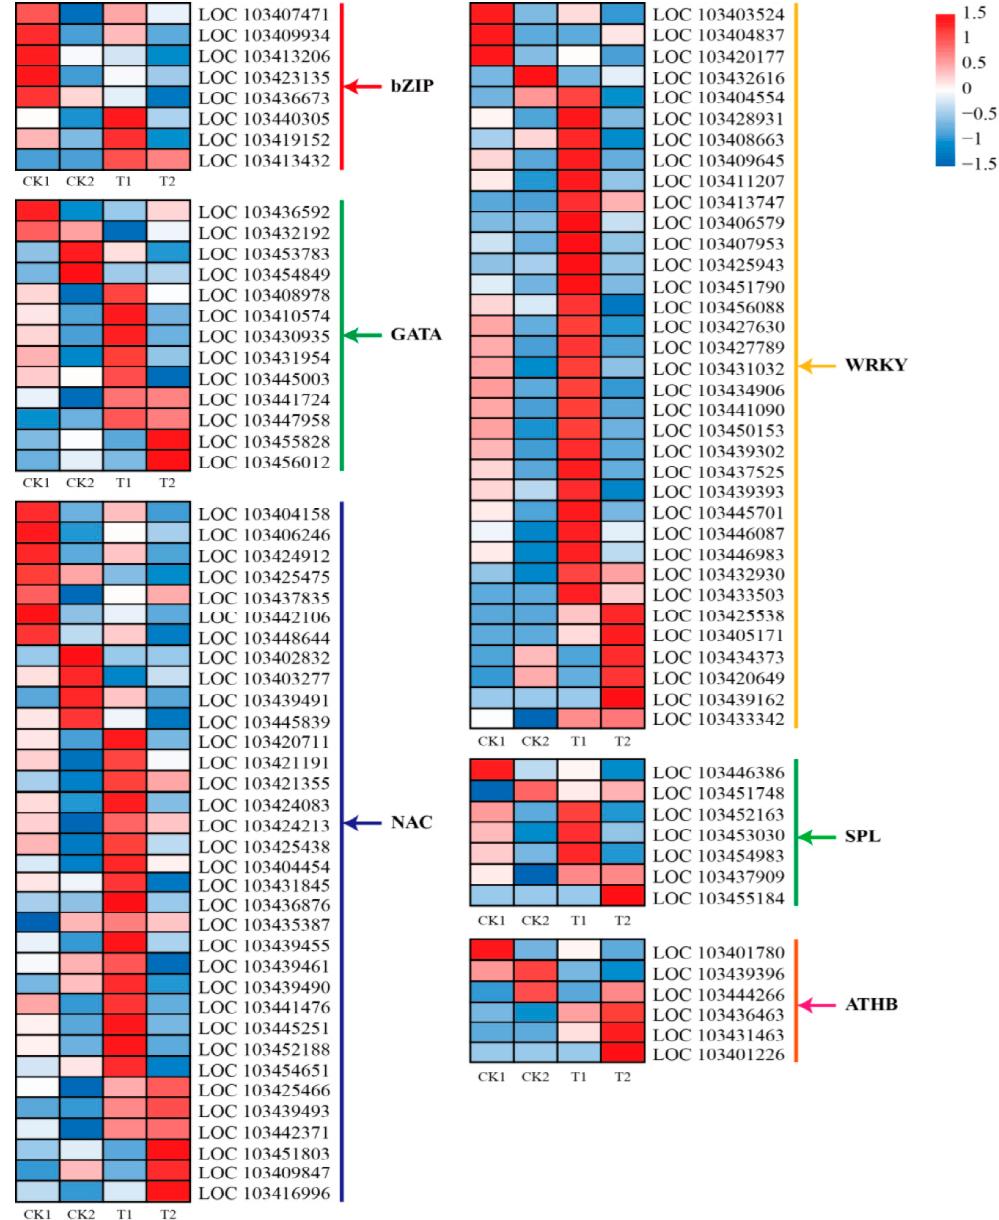
Figure 5. Heat map representation of the expression patterns of genes encoding transcription factors in “Granny Smith” apple skins. bZIP, basic region/leucine zipper motif; GATA, GATA zinc finger domain; NAC, NAM/ATAF/CUC; WRKY, protein domain containing a tryptophan-arginine-lysine-tyrosine amino acid motif; SPL, SQUAMOSA promoter-binding protein-like; ATHB, homeodomain leucine zipper proteins. Columns and rows in the heat map represent samples collected at different time points for which bags were removed. The color scale on the right represents the log-transformed FPKM value.